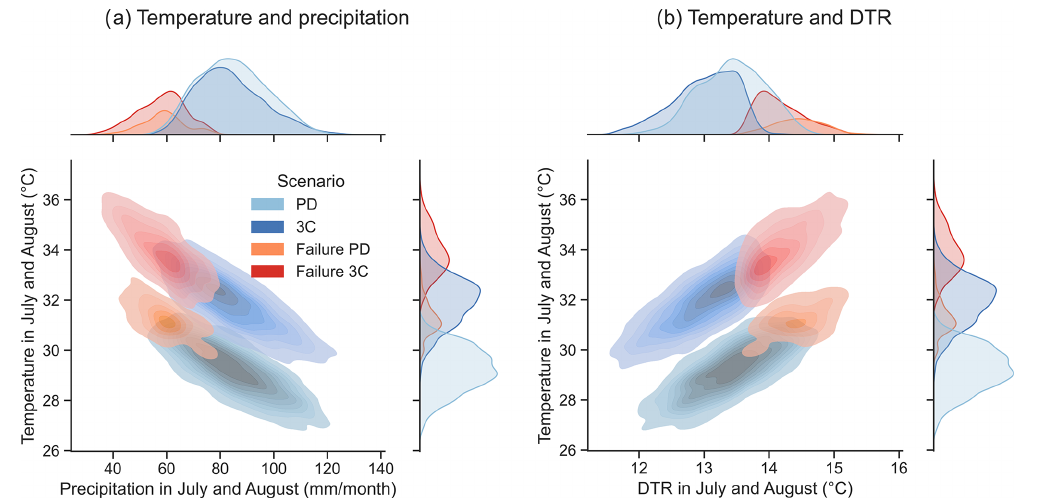
Figure 7. Kernel density estimate plots for seasons with and without failures at different GW scenarios: (a) for maximum monthly tempera- ture and precipitation and (b) temperature and diurnal temperature range.